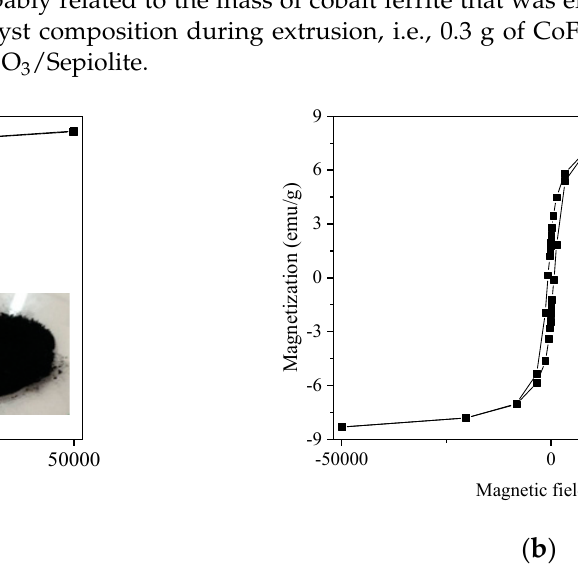
Figure 8. Magnetic characterization by VSM analysis for: ( a ) cobalt ferrites (CoFe 2 O 4 ) particles and ( b ) K 2 CO 3 / γ -Al 2 O 3 /sepiolite/CoFe 2 O 4 . Analysis conditions: M vs. T, give H 748 = 10,000 Oe as applied field and for the M vs. H, give T = 300 K.